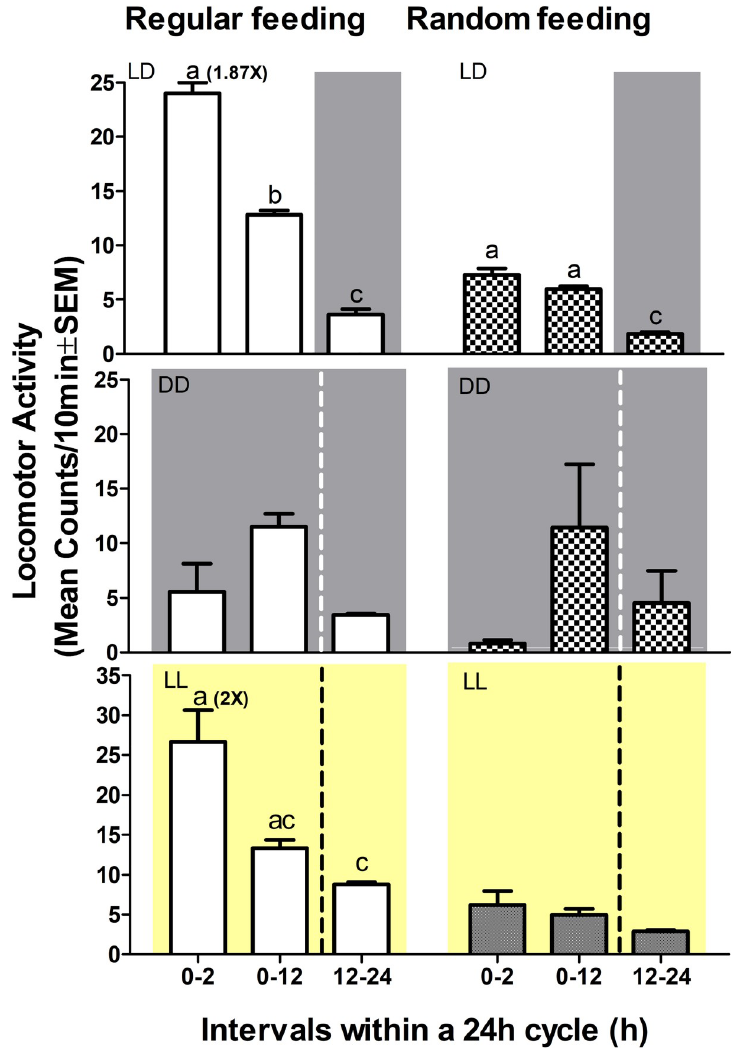
Fig 5. Preprandial locomotor activity in LD (top), DD (mid) and LL (bottom). Activity levels during the photophase (0–12) and scotophase (12–24) of a 24-h cycle from turbot. Within the photophase, activity levels were analyzed 2h before lunch time (0–2) and during the entire light phase (0–12) either in the group with a schedule feeding time at ZT2 or in the group randomly fed, in LD (top), DD (mid) and LL (bottom). Bar graphs show mean ± SEM. Significant differences between groups are indicated by letters. Scheduled feeding significantly stimulates increases in locomotor activity before feeding time under LD and LL but not under DD conditions (Kruskal-Wallis one way anova: H = 73.73, df 3, p < 0.05 and post hoc by the Dunn’s test p < 0.001). No changes in locomotor activity were observed upon the onset of light period compared with the whole light phase in randomly fed